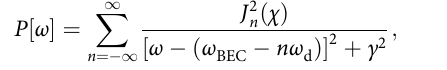
one or several phonons) are ampli fi ed, but the anti-Stokes ones (annihilation of a phonon) are not. This asymmetry is attributed for the Stokes processes, but not for the anti-Stokes ones 28 . In fact, the probe beam can only resonantly couple to modes with energy higher than that of the BEC. On the contrary, no modes are available at energies below the BEC, thus strongly suppres- sing this channel. The observation of up to fi ve replicas of the 20 GHz phonon evidences a strikingly ef fi cient optomechanical interaction.